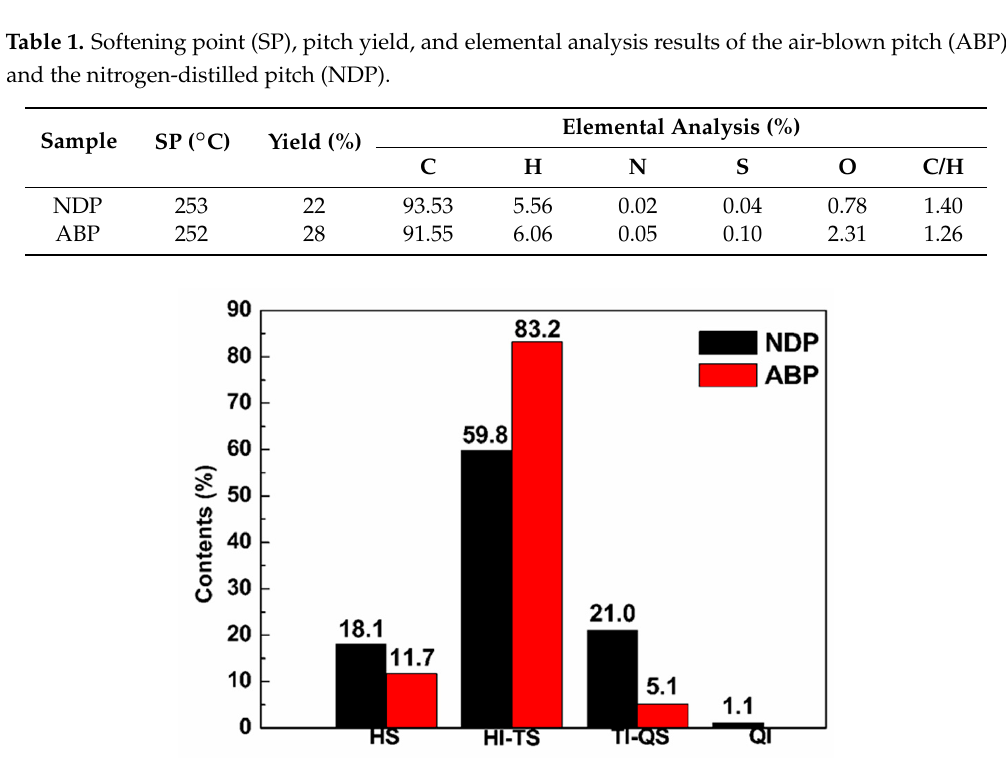
Figure 1. Solubility parameter ( n -hexane soluble (HS), n -hexane insoluble and toluene soluble (HI-TS), toluene insoluble and quinoline soluble (TI-QS), and quinoline insoluble (QI)) of the NDP and the ABP.